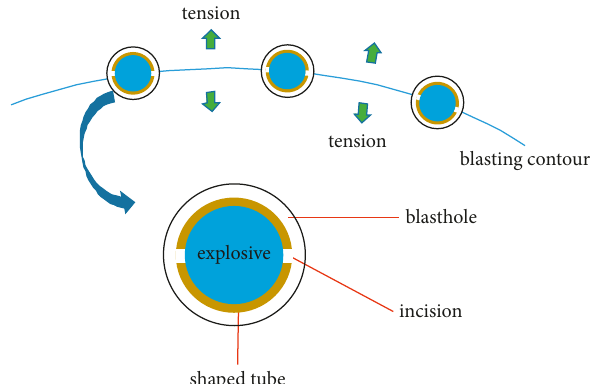
Figure 19: Energy-concentrated blasting of tunnel face.